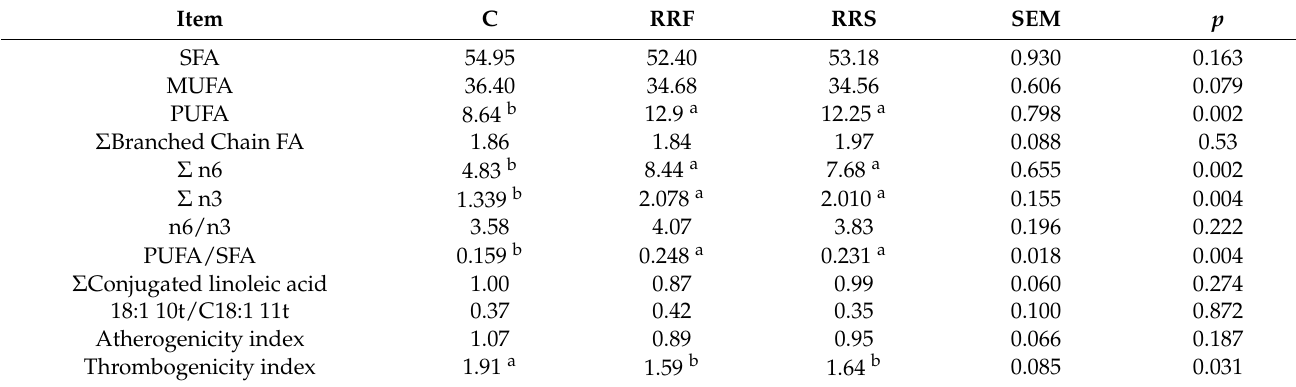
Table 5. Effect of the inclusion of rosemary residues on fatty acid groups (mg FA/100 g